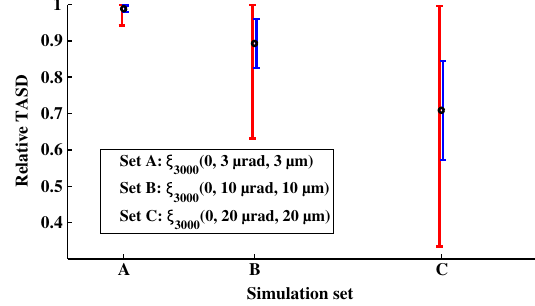
FIG. 15. Statistical distribution of the relative TASD for differ- ent values of ΔΘ and Δ Ξ (3000 events per point). The points describe the average relative TASD of the data. The error bars on the left of each point represent the extreme values of the data and the ones on the right of each point represent the